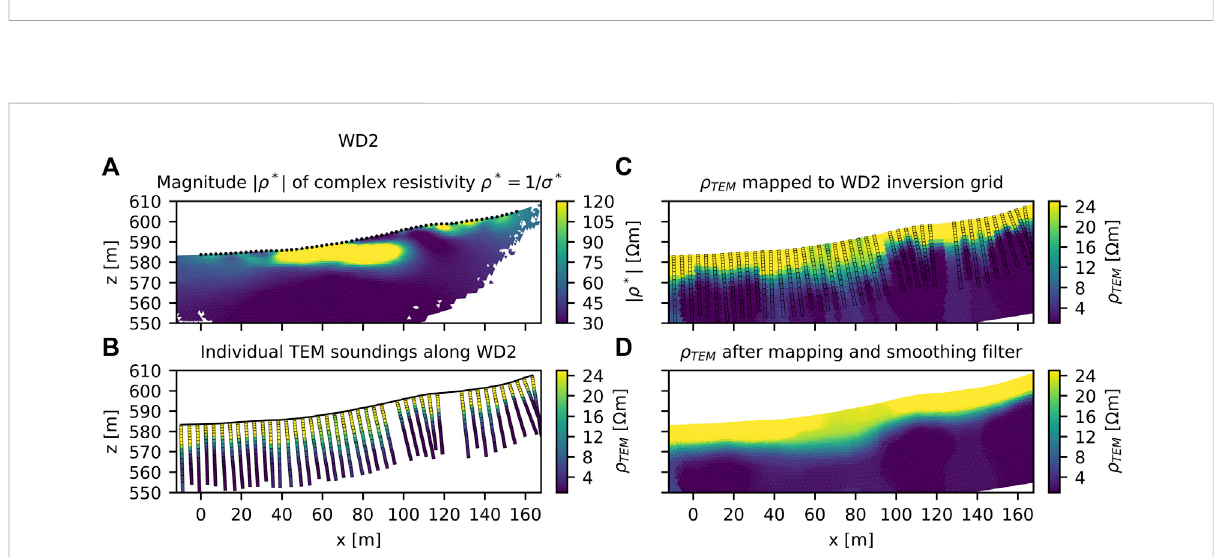
FIGURE 4 (A) Electrical imaging results for the pro fi le WD2 expressed in terms of the magnitude | ρ p | of the complex resistivity ρ p = 1/ σ p , as well as (B) the invertedTEMdatacollectedalongthesamepro fi le. (C) showsTEMresistivityvalues ρ TEM mappedtotheinversiongridofWD2usingnearestneighbor interpolation and (D) the same section after applying a smoothing fi